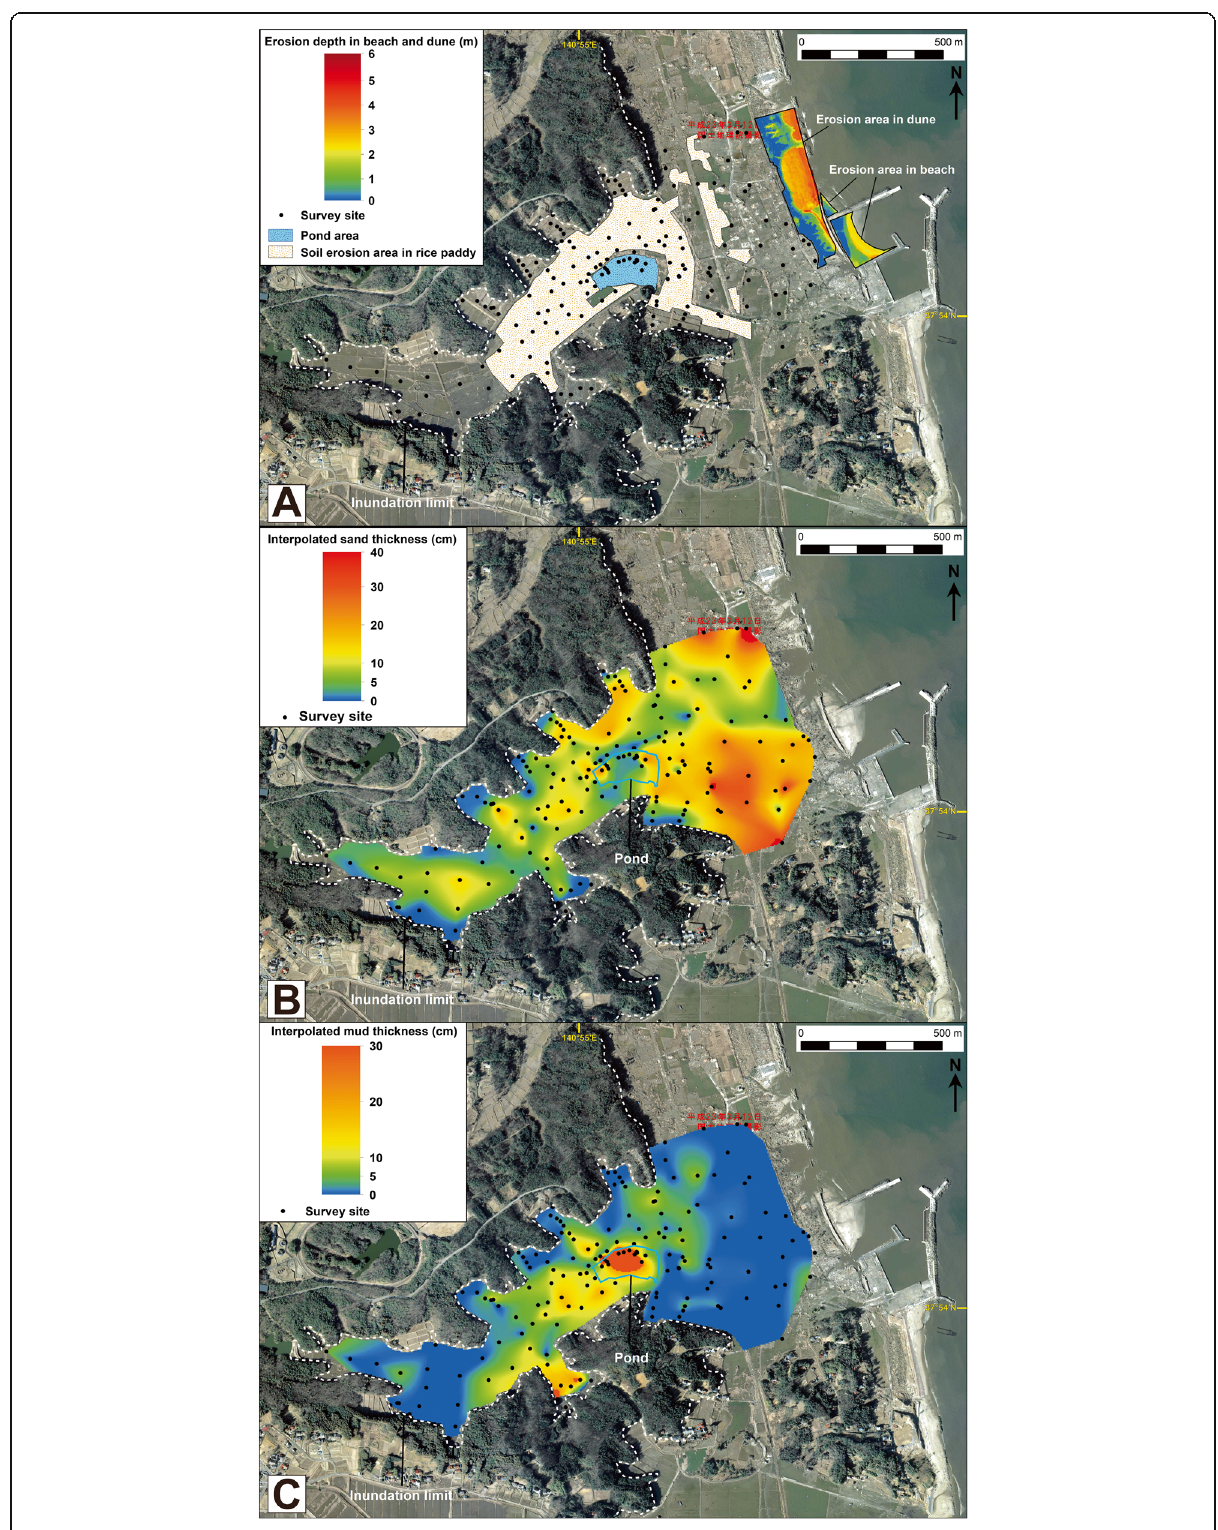
Fig. 9 Estimation of erosion and deposition by the tsunami in study area: a a sand erosion depth in sandy beach and sand dune, and a soil erosion area in a rice paddy; b spatial distribution of interpolated sand thickness; and c spatial distribution of interpolated mud thickness. Base map is an aerial photograph taken on the day after the tsunami which was provided by